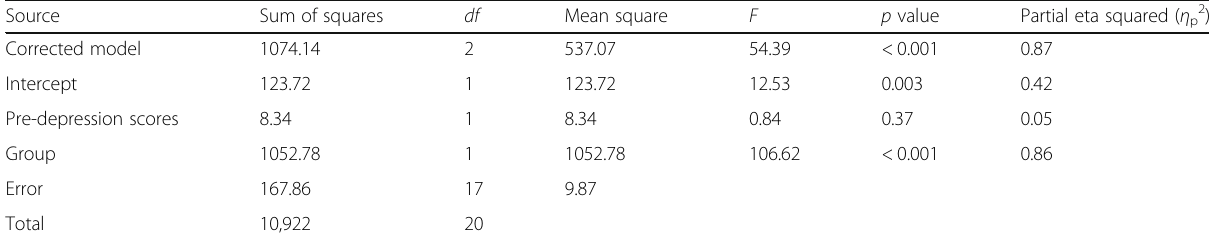
Table 4 Results of ANCOVA test for DBT treatment group